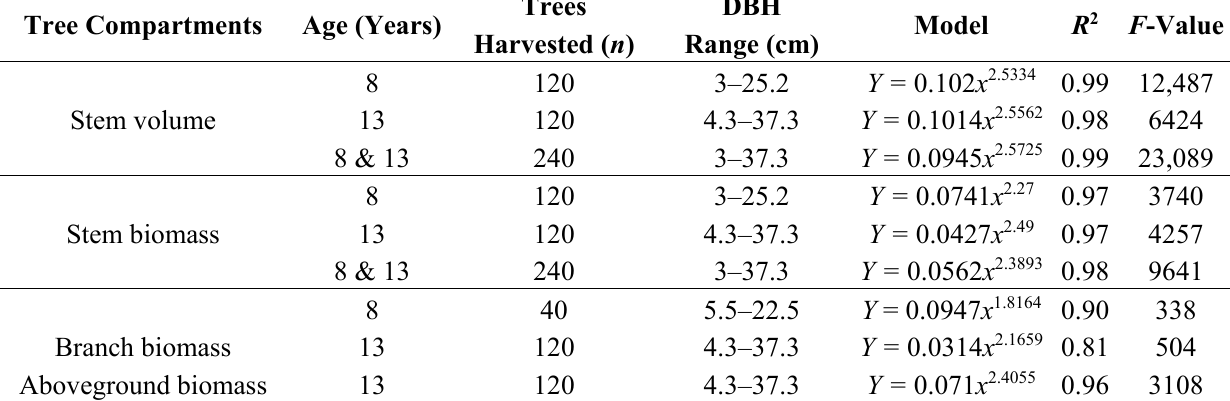
Table 3. General (5 clones) allometric relationships between diameter at breast height (cm), as the predictor variable ( x ), and stem volume (dm 3 ), stem dry biomass (kg), branch dry biomass (kg), and woody aboveground dry biomass as the response variables ( Y ). Allometric relationships for 8 year-old poplars are from Truax et al.